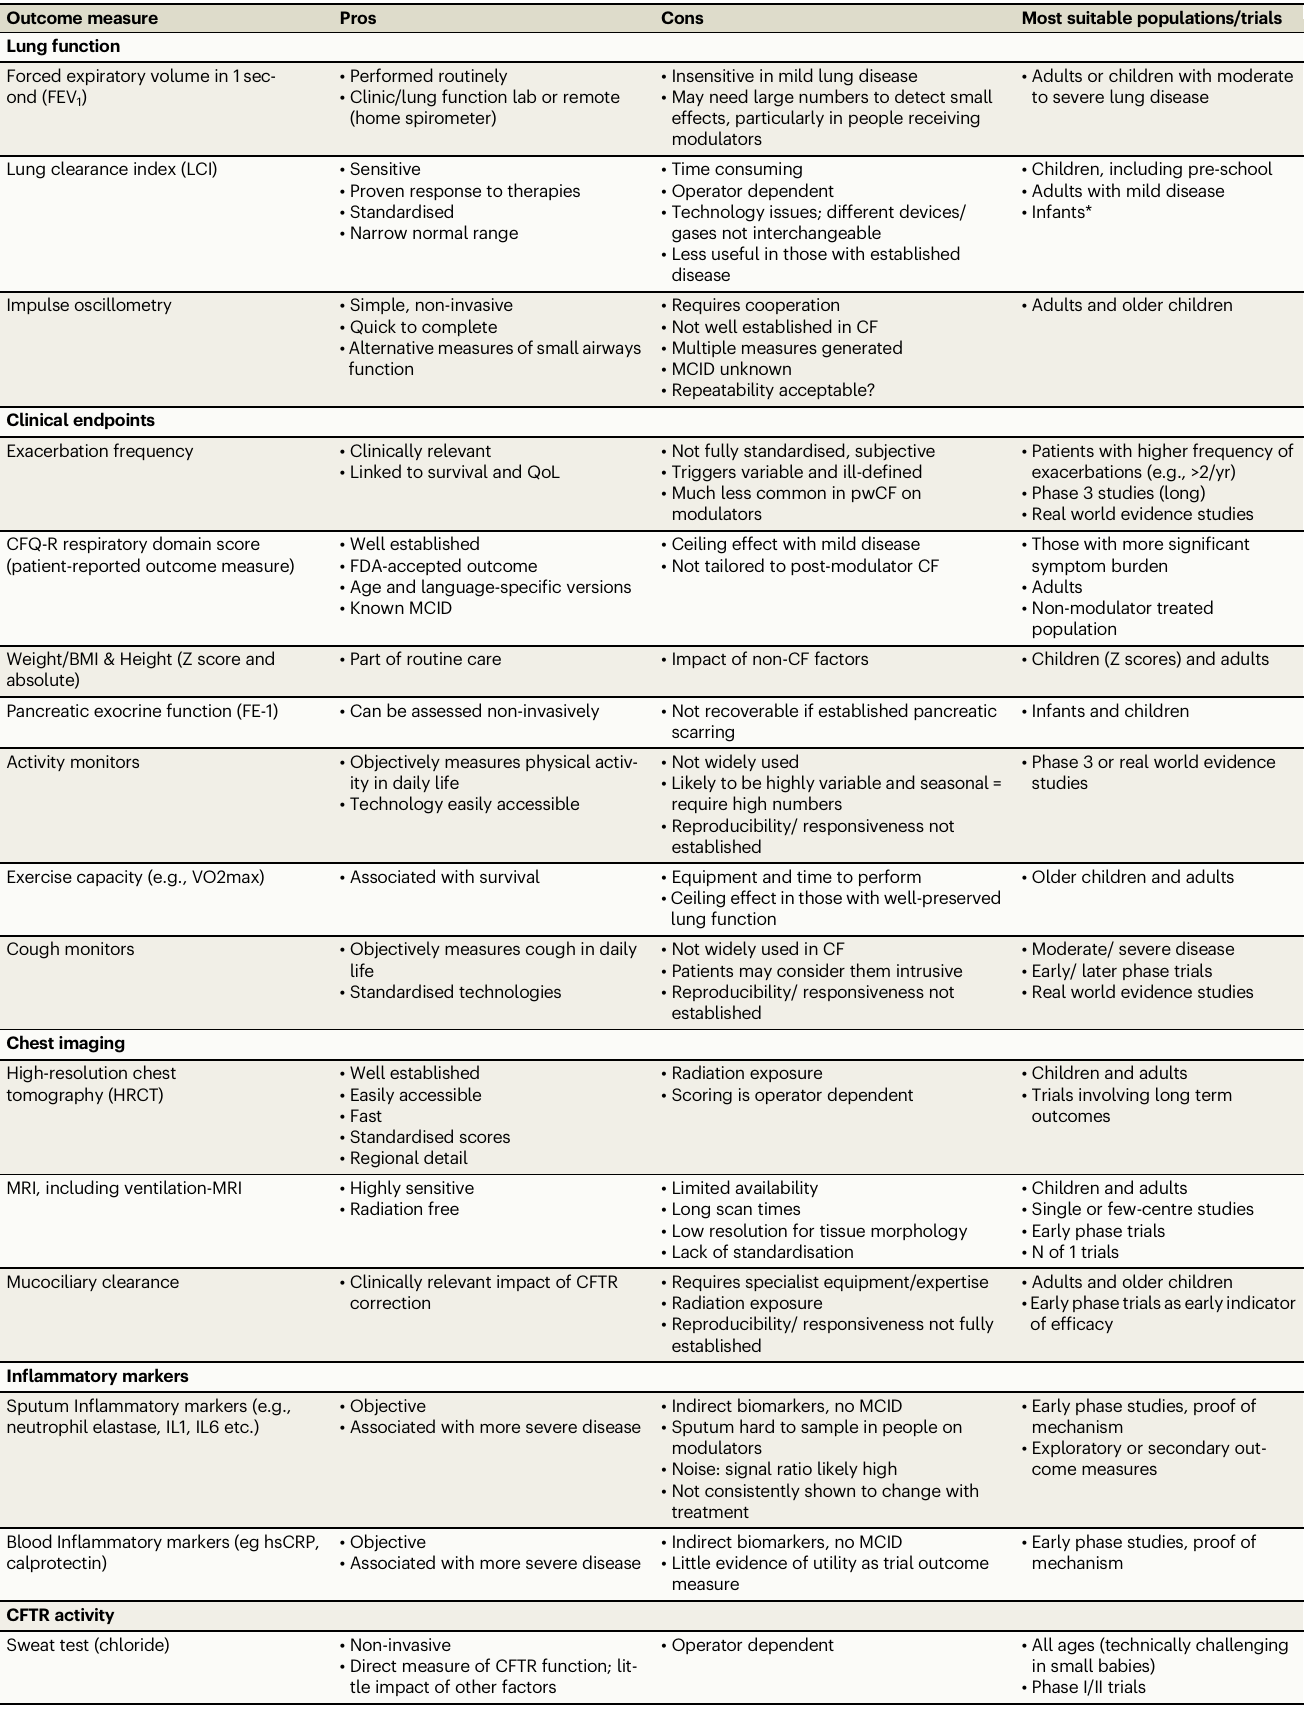
Table 1 | Pros, cons and optimal use of current and future CF trial outcome measures Outcome